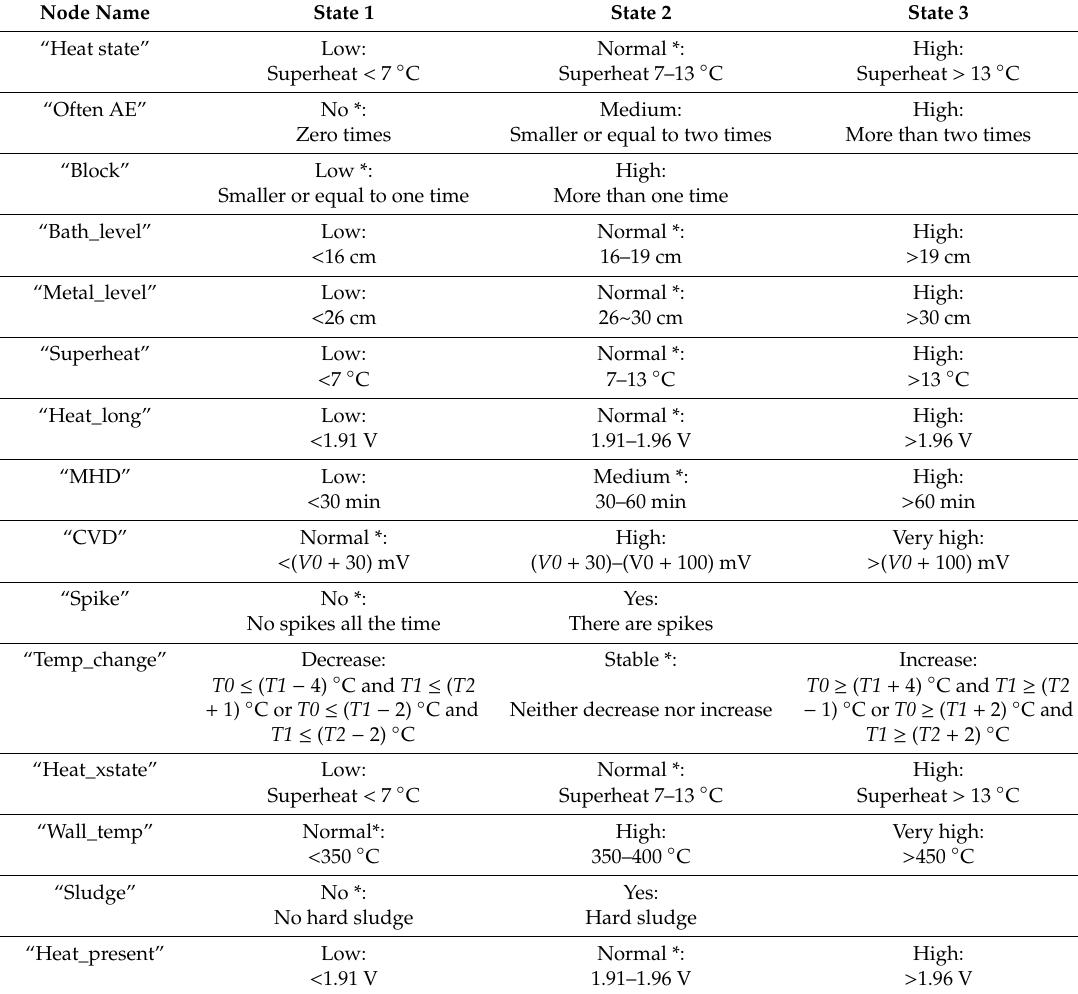
Table 1. Selected nodes and state discretization (State with * is default